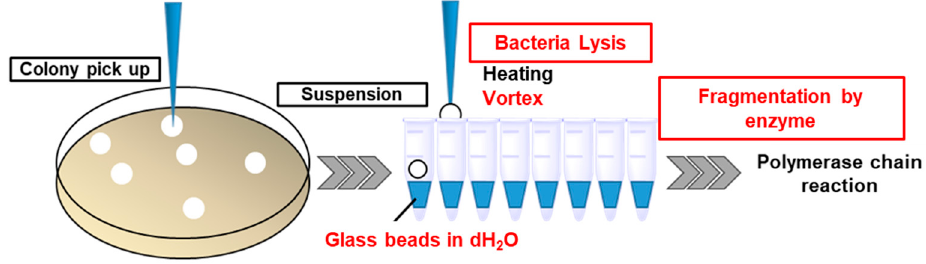
Figure 1. Optimized preparation protocol of DNA templates for colony PCR. Red highlighting indicates the optimized steps.